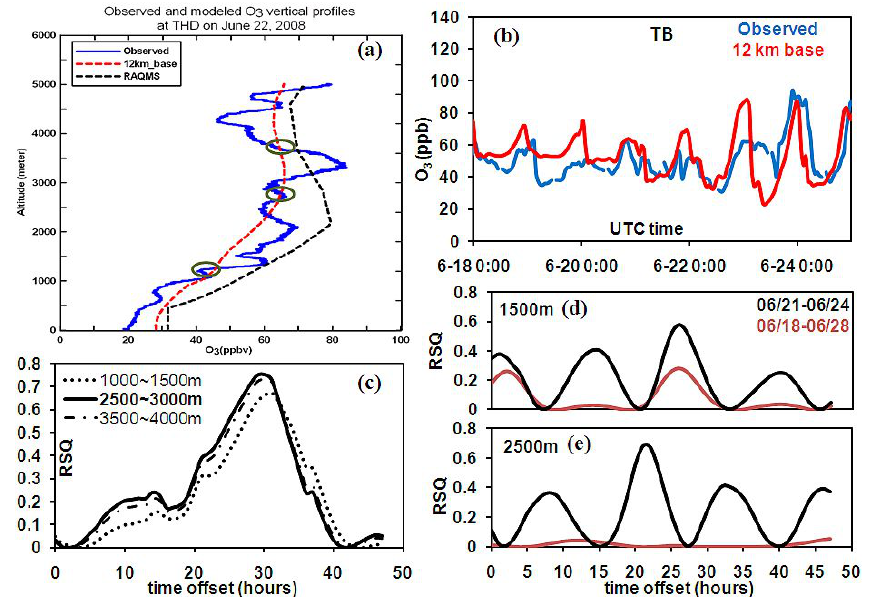
Fig. 9. Observed and 12 km-modeled O 3 profiles at (a) THD and (b) TB; the correlation analysis based on (c) observations and (d–e) 12km model results.